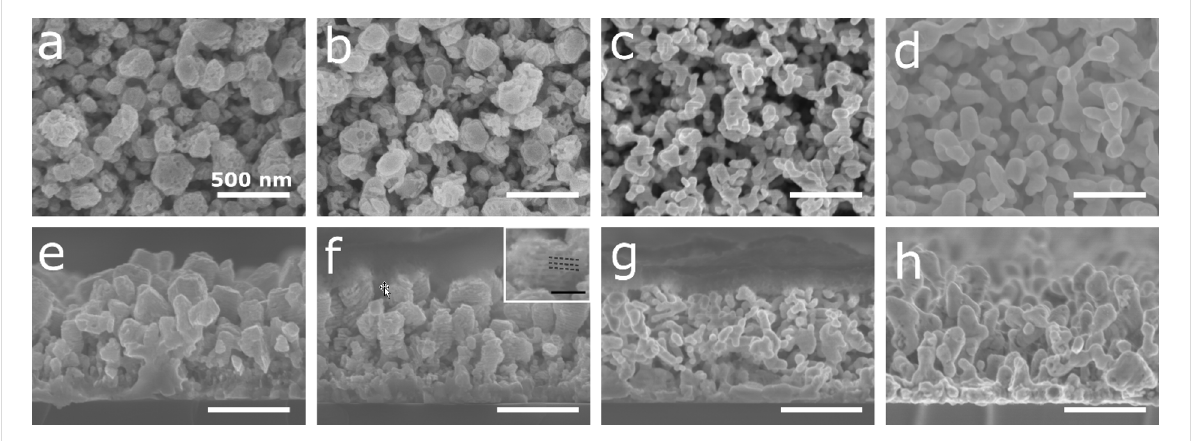
Figure 2: (a–d) Plan view and (e–h) cross-section SEM images of the Ag–Al alloy thin film with an initial composition of 30 atom % of Ag and de- alloyed for (a and e) 10, (b and f) 30, (c and g) 60, and (d and h) 120 min in an HCl solution at 1 wt %. Scale bar: 500 nm. Inset of panel (f) corre- sponds to a magnification of a nanolayered structure, the dashed lines highlight a full layer. Scale bar 100 nm.